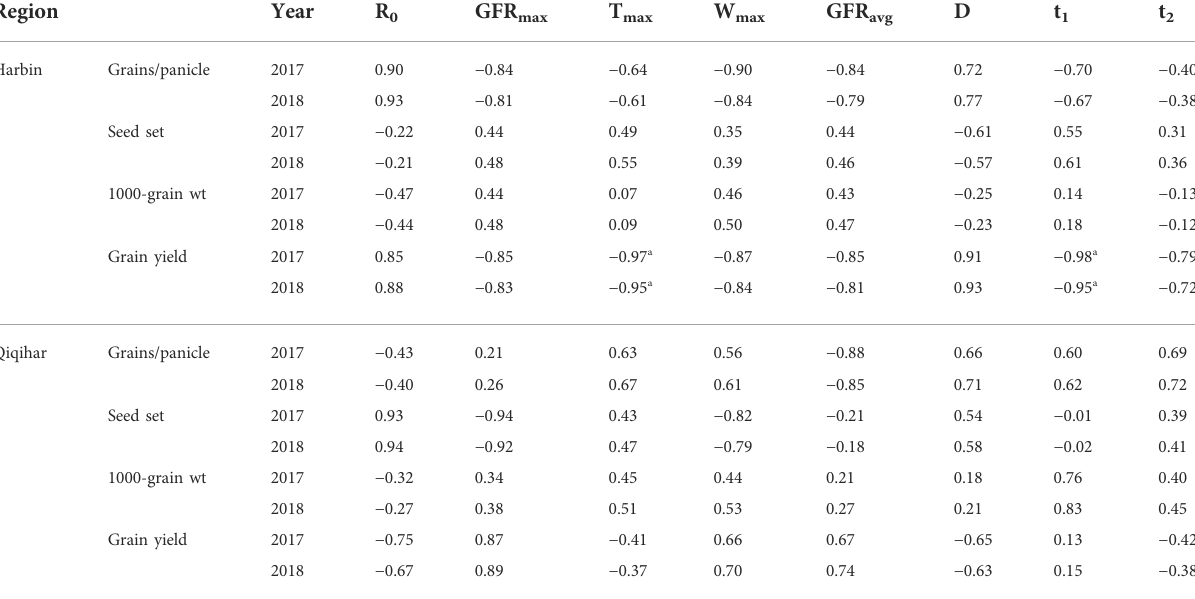
TABLE 7 Relationships between the grain- fi lling characteristic parameters of inferior grains, yield, and yield components in Harbin and Qiqihar, 2017 and 2018. Region